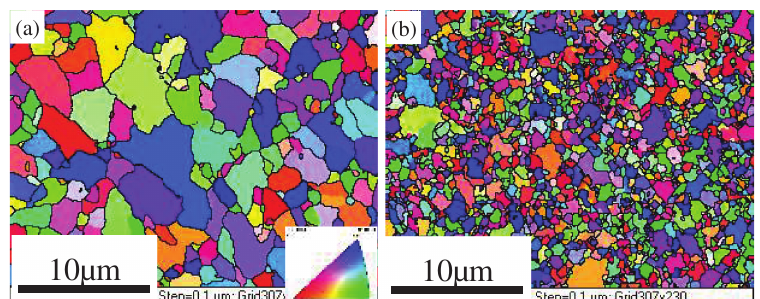
Figure 1: Inversed pole figures (IPF) maps of